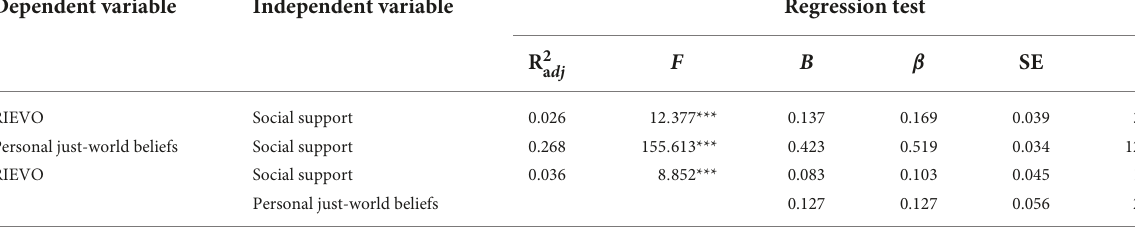
TABLE 4 Results of the regression for mediating effects of personal just-world